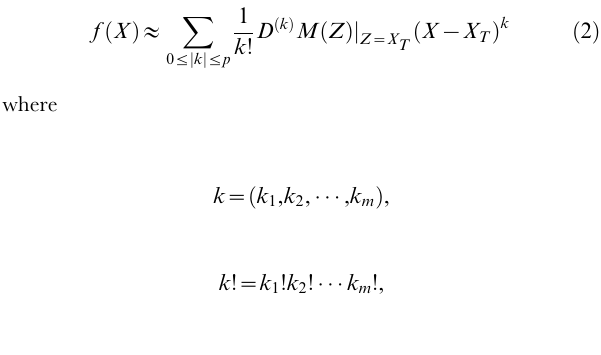
Table 1. True value and fitted value at points.